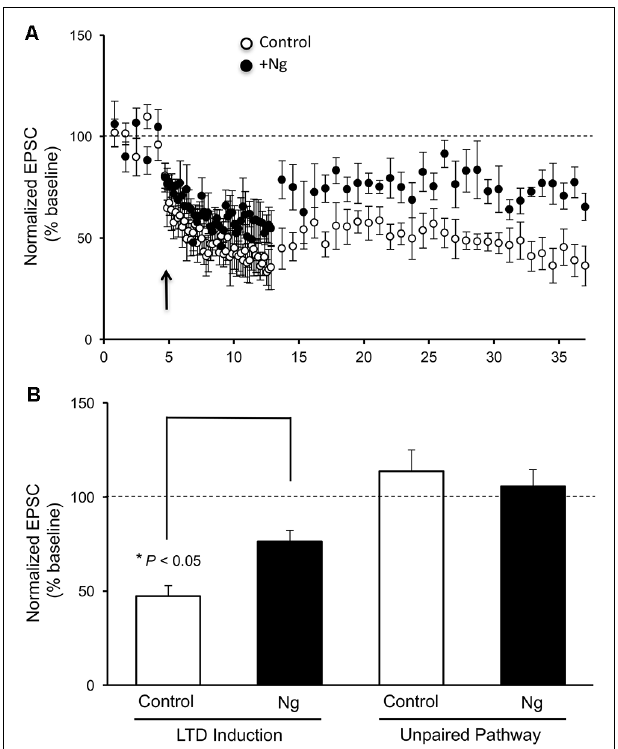
FIGURE 1 | Neurogranin (Ng) decreases long-term depression (LTD) expression in CA1 hippocampal pyramidal neurons. (A) LTD was induced by pairing 1-Hz presynaptic stimulation (500 pulses) with − 40 mV postsynaptic depolarization (indicated with an arrow) in neurons expressing GFP-Ng (black circles, n = 7) and control uninfected neurons (open circles, n = 8). (B) Normalized average steady-state AMPAR-mediated responses (between 25–37 min) in unpaired (control pathway) and paired (LTD pathway) pathways for uninfected neurons and those expressing GFP-Ng. Pairing significantly decreased AMPAR-mediated responses in both groups. Neurons expressing GFP-Ng showed decreased expression of LTD, compared to control neurons ( p < 0.05).